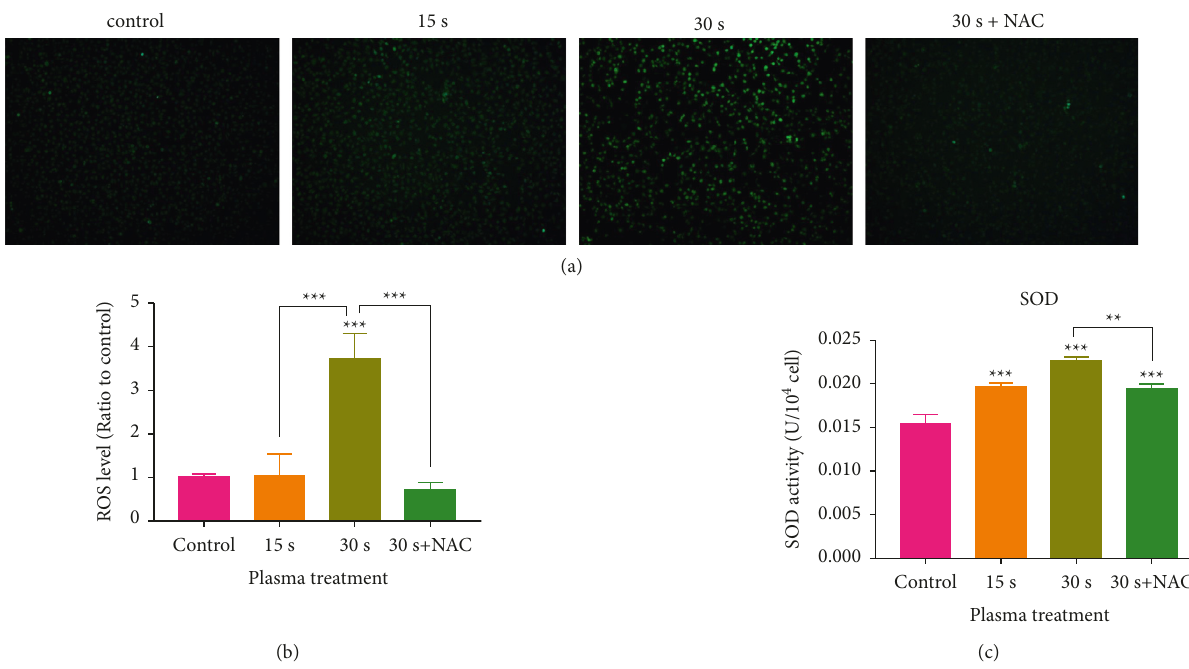
Figure 4: Intracellular ROS levels. (a) Fluorescence images of intracellular ROS generation in CAL-62 cells. (b) The quantification by measuring fluorescence pixel intensity using ImageJ software. (c) The activity of SOD in CAL-62 cells. The data represent the mean three independent